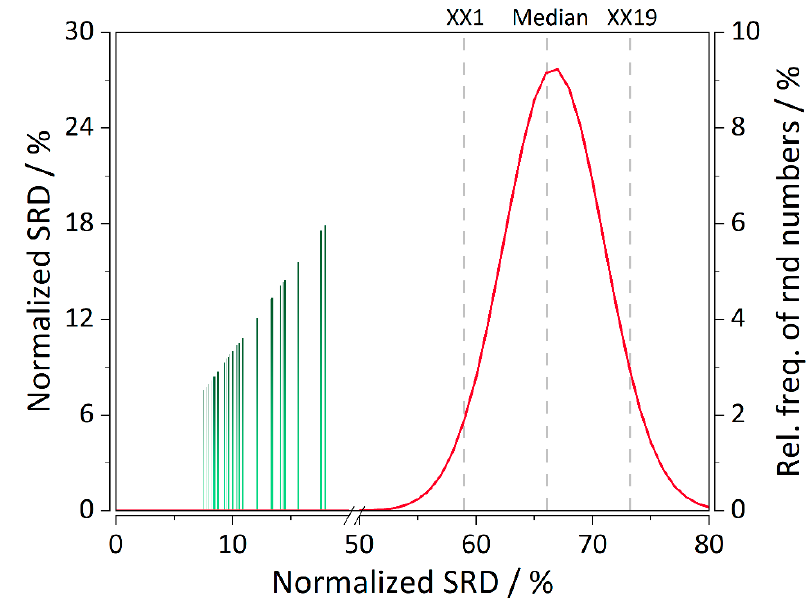
Figure 5. SRD analysis ranking the columns of the second case study according to their respective elution order predictions (“standard”: experimental elution order). Validated with normally distributed random numbers. SRD value of the first icosaile (XX1) was 59.00, median 66.10, whereas the last icosaile (XX9) was 73.2. Barplot legend (sorted ascending by SRD values): Xt(MLR-MOO) = 7.58; L2(MLR-MOO) = 7.71; L1(MLR) = 7.79; L4(MLR-MOO) = 7.91; L1(MLR-MOO) = 8.00; Xt(MLR) =